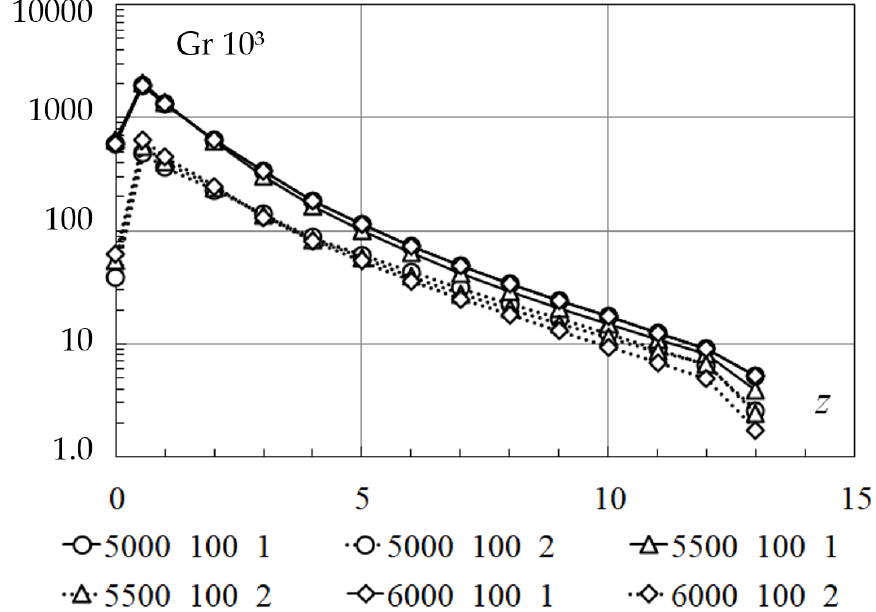
Figure 10. Changing the Grashof numbers along the length of the duct z [m] q 0 − Varia ; G − Const .